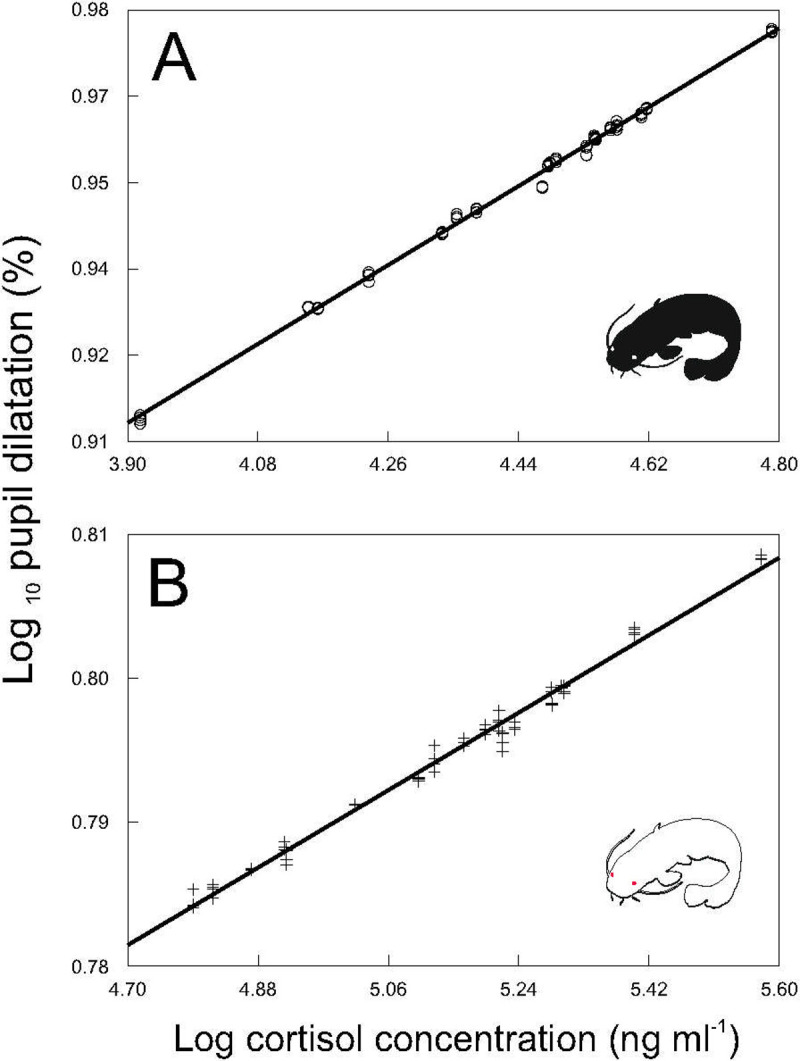
Relationship between pupil dilatation and cortisol blood concentrations.Values in pigmented (A; y = 0.6359 + 0.0711x; r2
= 0.99; P < 0.0001) and albino (B; y = 0.641 + 0.0299x; r2
= 0.98; P < 0.0001) catfish. Predicted values are from the mixed model analyses.